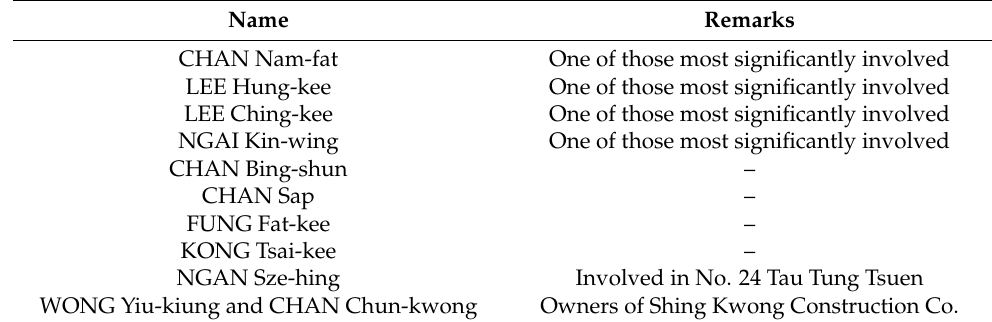
Table 3. List of developers identified from the Royal Hong Kong Police report in 1972 (City District Office 1972 HKRS 163